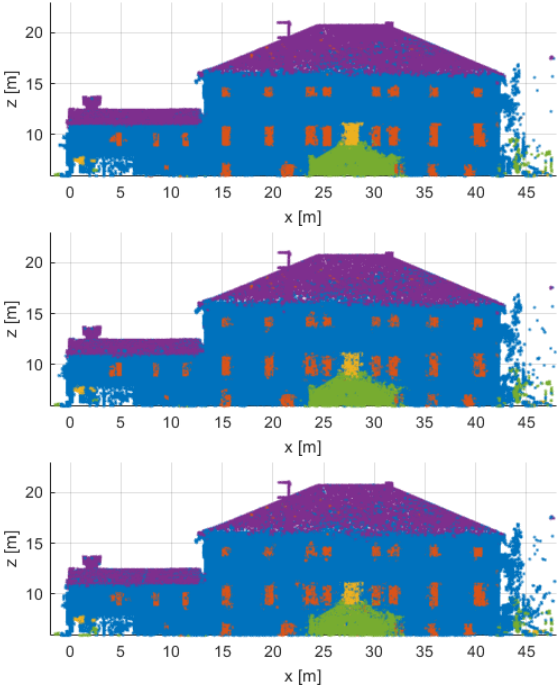
Figure 10. Predicted semantic segmentation of Villa Roberti Bru- gine: most popular vote approach (case B)) increasing (from the top to the bottom row) the noise level in the synthetic labeled im-